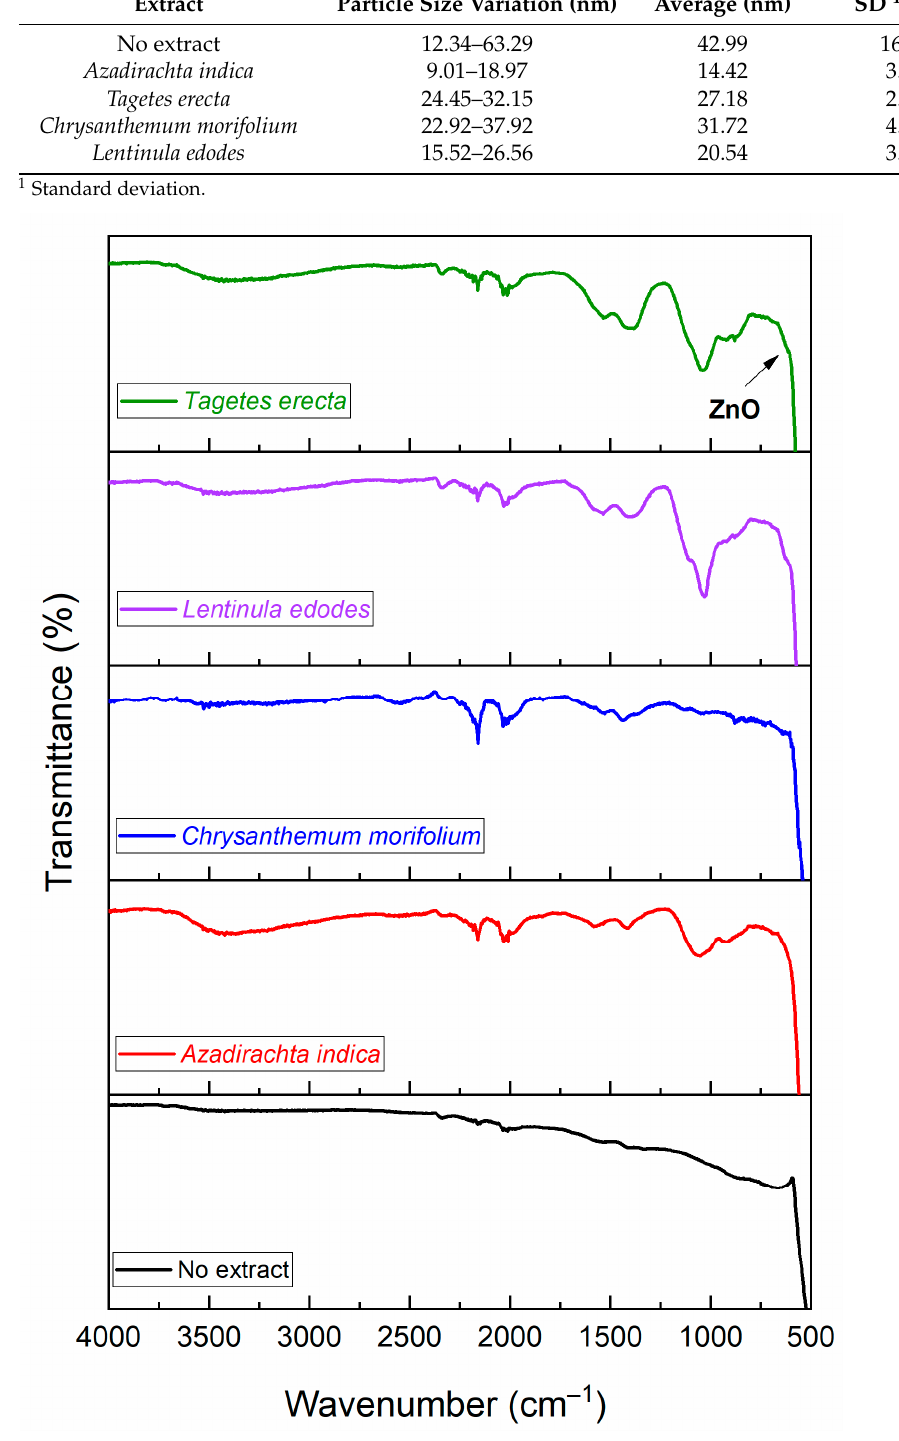
Figure 2. FTIR spectra for ZnO NPs synthesized with different botanical extracts.